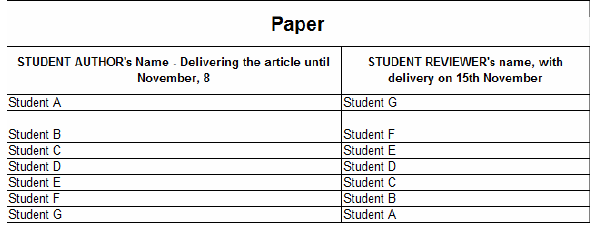
Figure 1. Student-authors and corresponding Student-reviewers